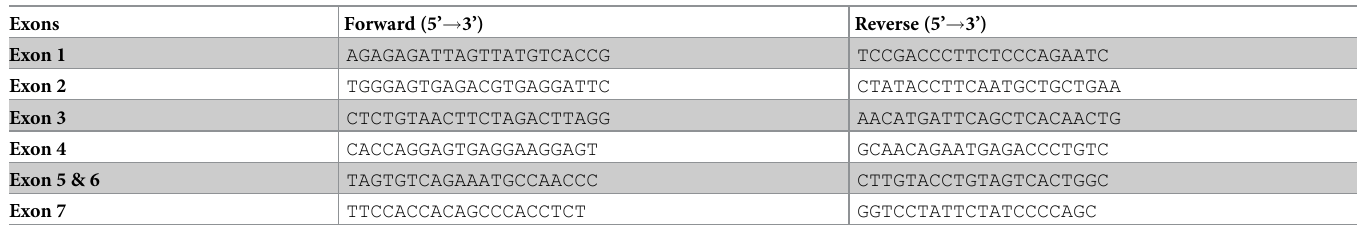
Table 2. Primers used for screening mutation in UBAP1